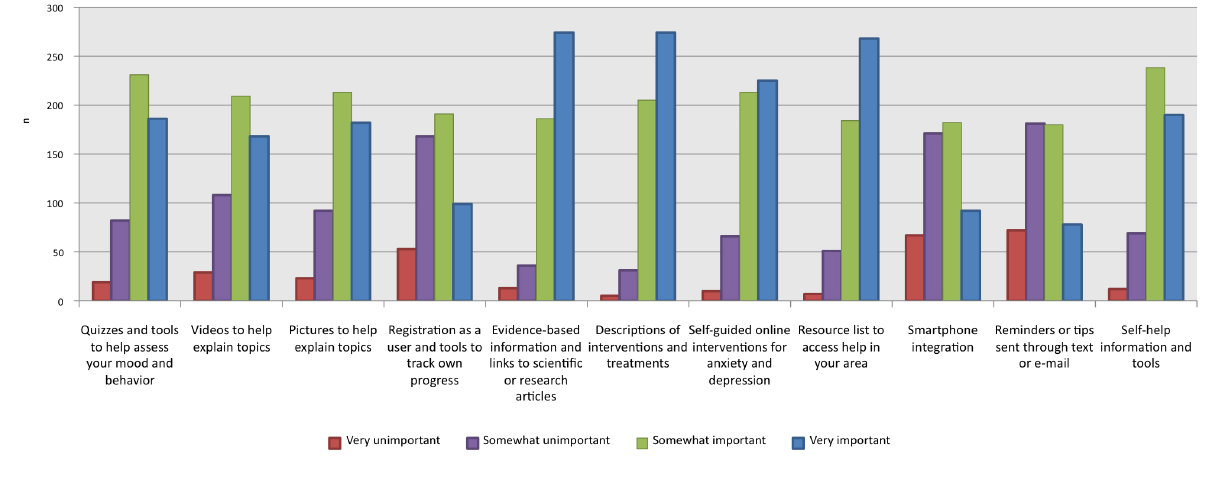
Figure 3. Importance of different features within a Web-based mental health